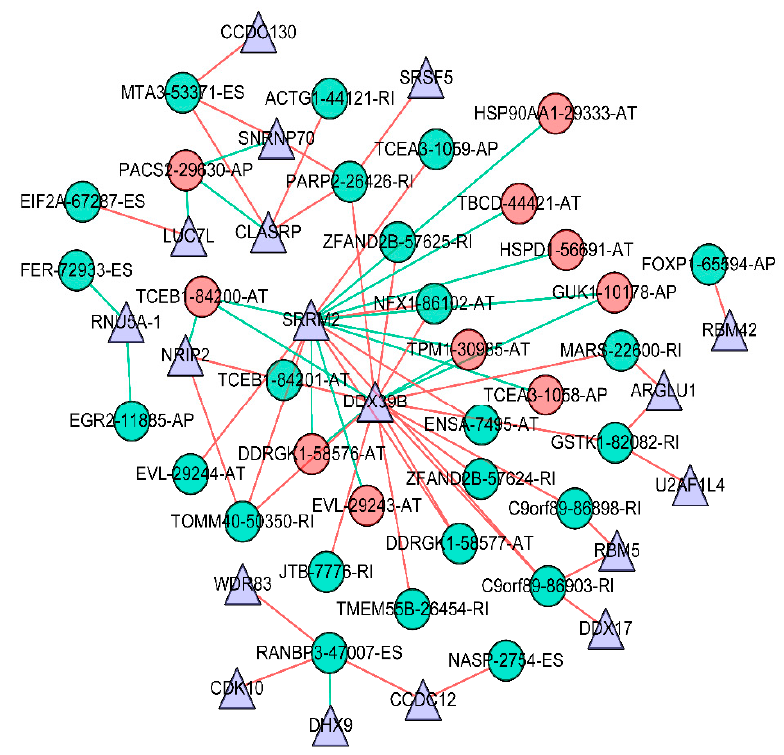
Figure 8. Survival-associated potential SF–AS regulatory network in breast cancer. Triangles ( n = 18) represent SFs, red circles represent AS events associated with poor prognosis, green circles represent AS events associated with favorable prognosis, red lines indicate a positive regulation between AS and SF, and green lines indicate a negative regulation between AS and